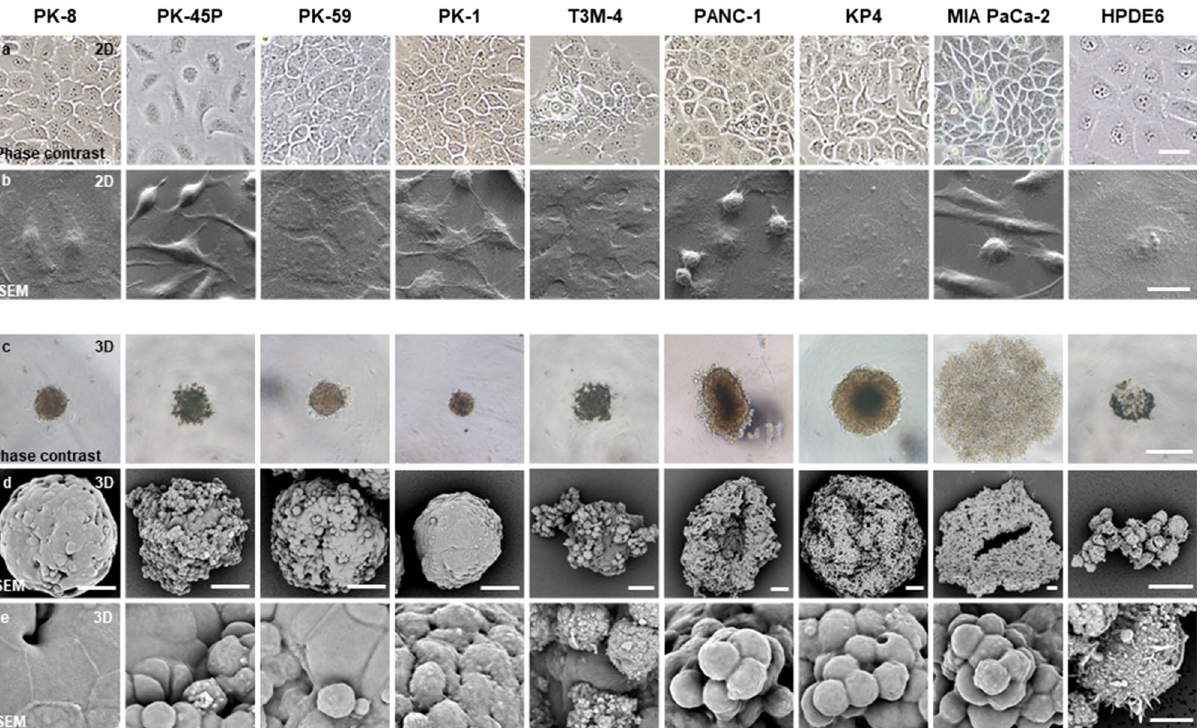
PDAC cells had complete or incomplete lining cells with flat cell surfaces under SEM. Scale bars: a = 50 μm; b = 20 μm; c = 500 µm; d = 50 µm; e = 10